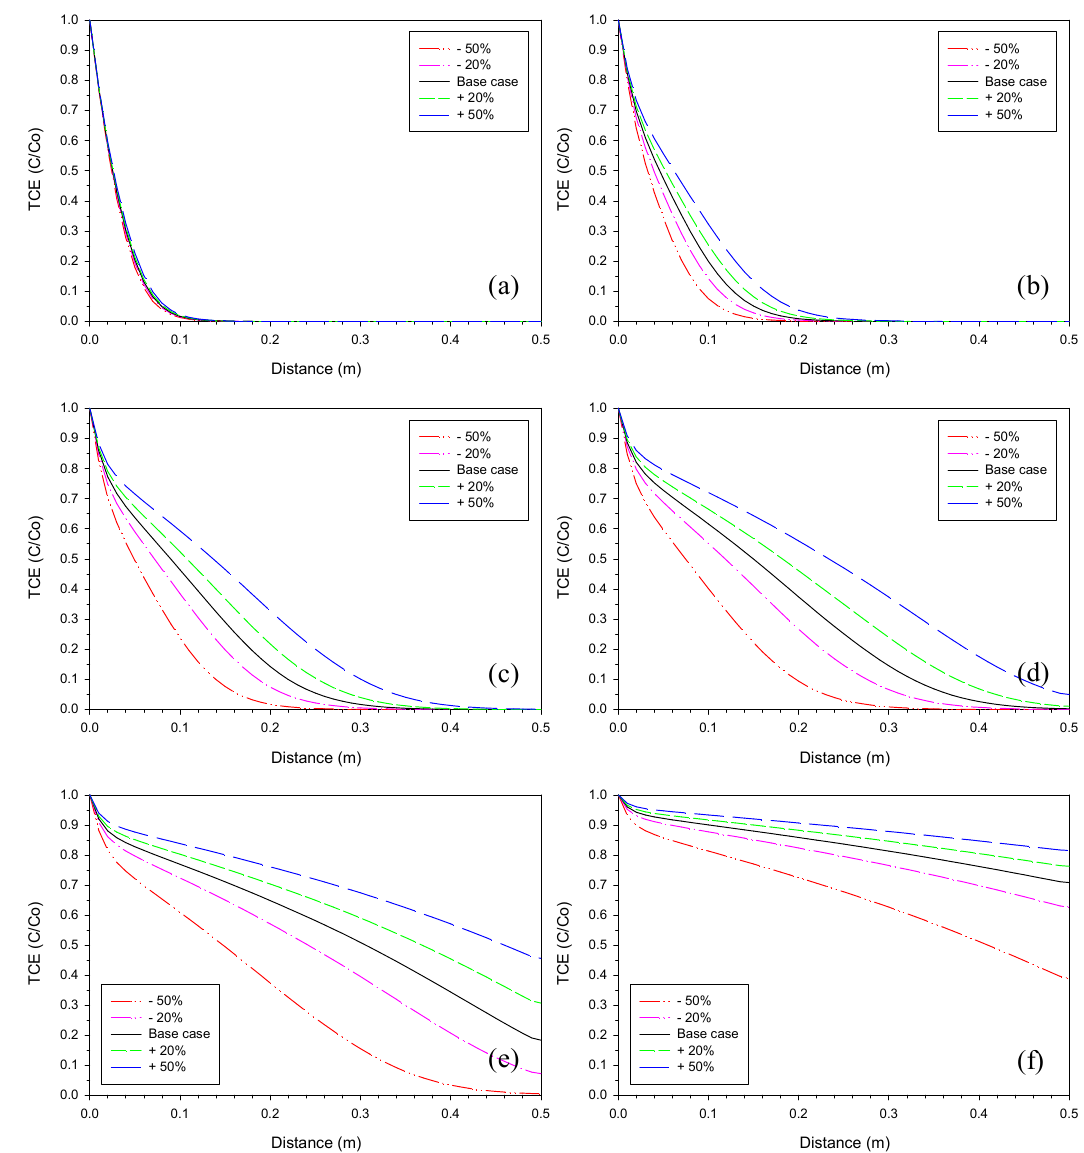
Figure 7. Sensitivity analysis of α 1 (proportionality constant for aragonite). TCE profiles on ( a ) Day 4, ( b ) Day 25, ( c ) Day 54, ( d ) Day 87, ( e ) Day 164, and ( f ) Day 410 with value of the base case, +/−20% and +/−50%.